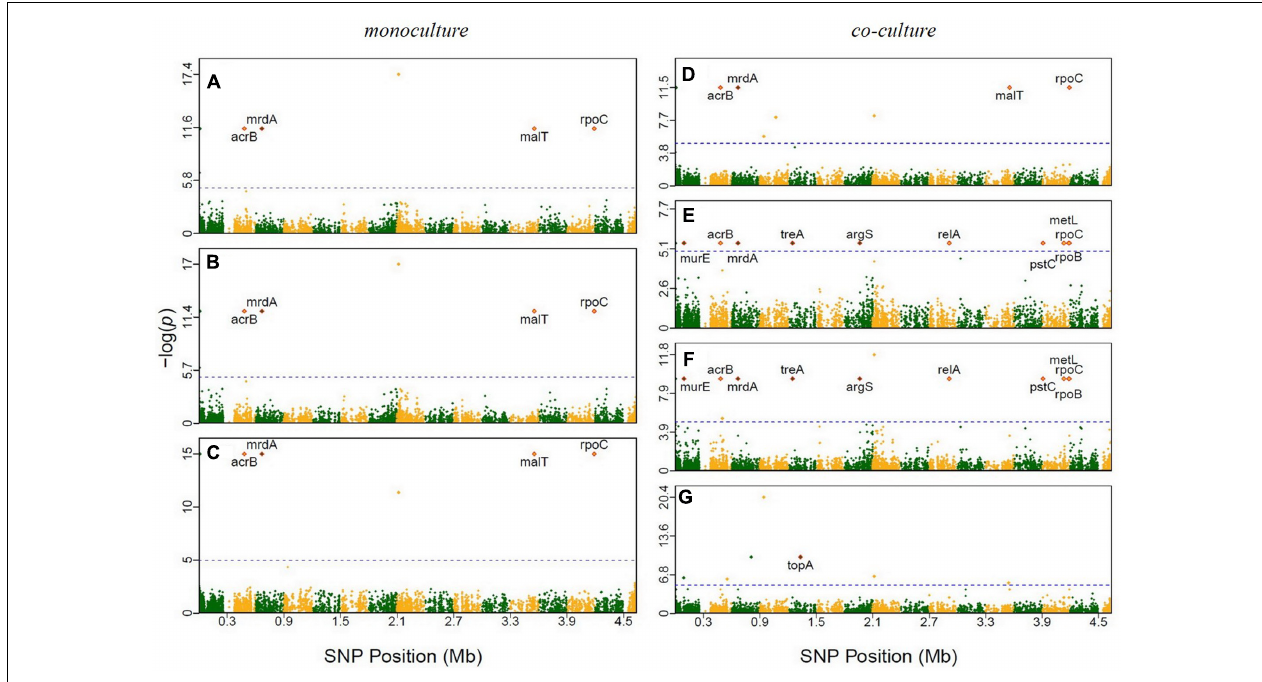
FIGURE 2 | Manhattan plots of GWAS results for E. coli grown in monoculture and co-culture. The x -axis showed SNP positions (Mb) and the y -axis was the –log( P -value) resulting from the association test. Each dot in the plot represented an SNP, and a reference line was used on the y -axis to reflect genome-wide significance. Significant SNP identified in previous evolutionary studies were highlighted. (A) Time point 2; (B) time point 7; (C) time point 14; (D) time point 1; (E) time point 6; (F) time point 10; (G) time point